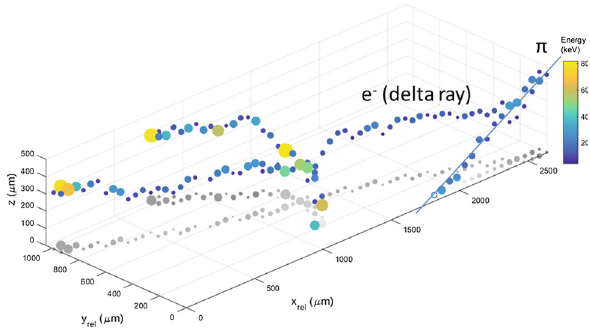
Fig. 10 Same as Fig. 9, but for a track from the measurement with 150V bias. The secondary particle’s track ends in a fork like structure with three prongs